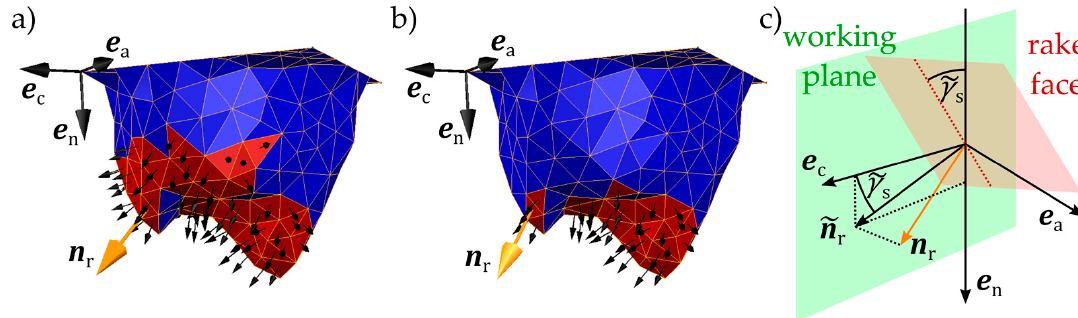
Figure 12. Calculation of the approximated rake angle (cid:101) γ s for a single grain. ( a ) Averaging of normal vectors in cutting direction for a higher value of the undeformed chip thickness h s cu . ( b ) Averaging of normal vectors for a smaller value of h s cu . ( c ) Schematic projection of the average normal vector n r into the working plane and calculation of the approximated rake angle (cid:101) γ s